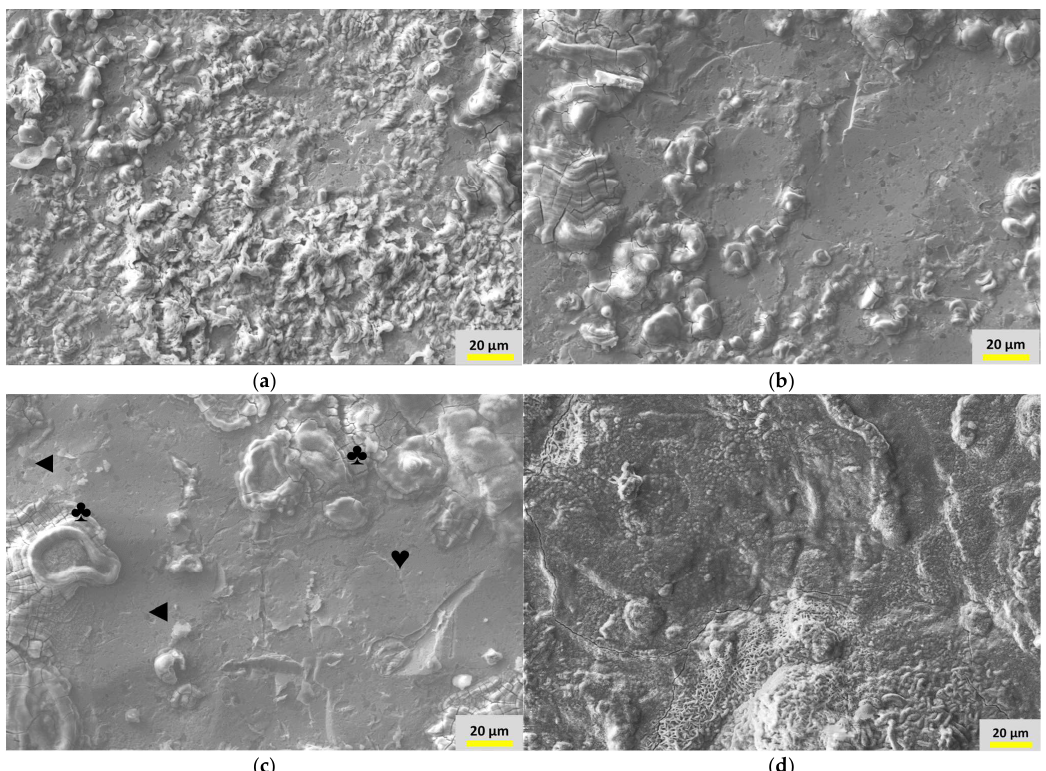
Figure 10. SEM photograph of a polished coupon.